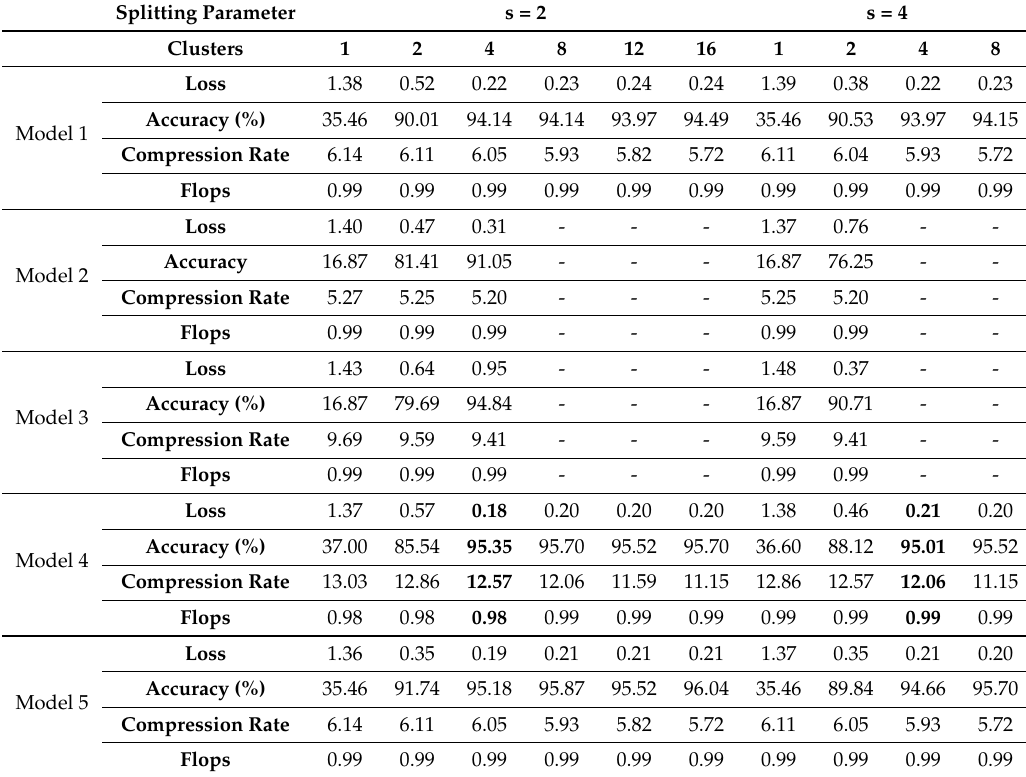
Table 12. Product quantization for all combinations of clusters and s = 2,4 on fully connected layer only. Splitting